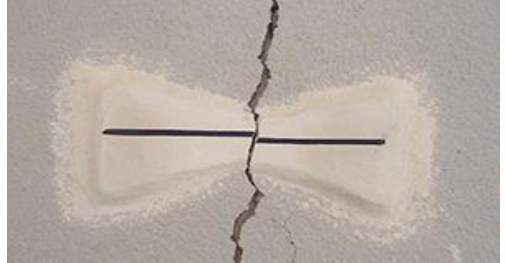
Figure 1. Example of gypsum marker Figure 2. Example scale-based and mechanical crack